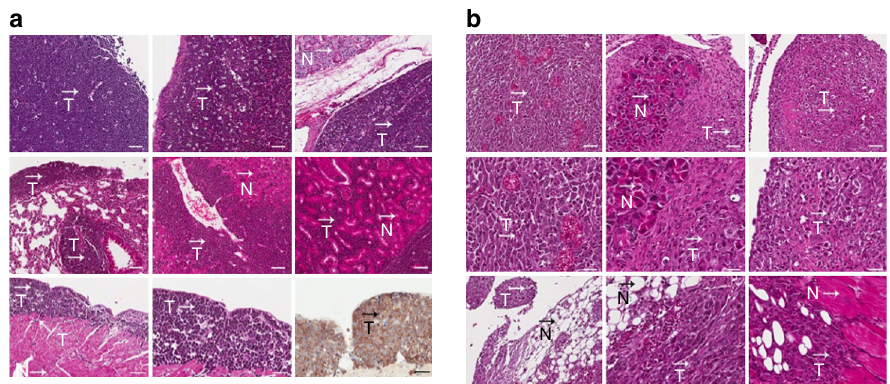
Fig. 3 Loss of IL-6 leads to reduced metastatic spread of tumours in Δ 122p53 mice. Necropsies were carried out on cohorts of mice from each genotype and histological examination carried out to ascertain tumour type and evidence of invasion. a Examples of photomicrographs illustrating histological (H&E) and immunohistochemical staining (chromogen-brown) of a T-cell lymphoma from a Δ 122/ Δ 122 IL-6 + / + mouse. From left to right, top to bottom, at ×100 magni fi cation: primary T-cell lymphoma in the thymus; tumour spread to spleen, salivary gland node, lung, liver, kidney, heart, heart (×200); and CD3 staining (×200) of the heart. Scale bar = 50 μ m (top and middle row), 50 μ m (bottom — left) and 25 μ m (bottom middle and bottom right). b Examples of photomicrographs illustrating histopathological (H&E) staining of a metastatic sarcoma from a Δ 122/ Δ 122 IL-6 + / + mouse. From left to right, top: primary sarcoma in the abdomen and metastases to pancreas and pancreatic node (×100); middle: the same at higher magni fi cation (×200); bottom: metastases involving adipose tissue at ×100 and ×200 magni fi cation, and metastases involving skeletal muscle (×200). Scale bar = 50 μ m (top row), 25 μ m (middle row) and 50 μ m (bottom — left) and 25 μ m (bottom middle and bottom right). T denotes tumour and N denotes normal tissue. ×100 magni fi cation unless otherwise stated